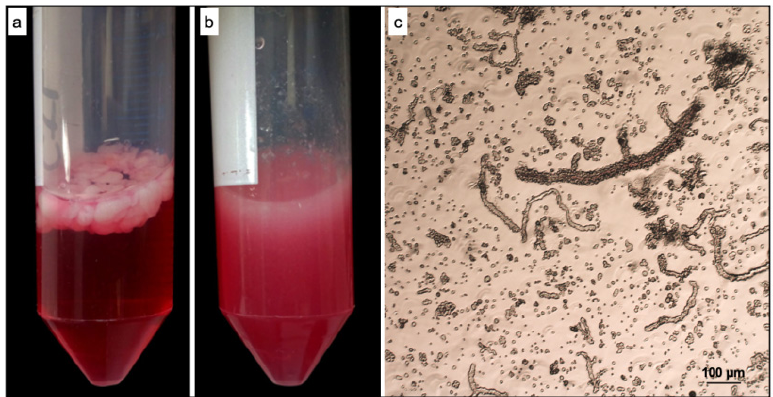
Figure 1. Isolation of stromal vascular fragments (ad-MVFs) from rat adipose tissue. ( a ) Rat adipose tissue before digestion. ( b ) Rat adipose tissue after digestion. ( c ) Optical microscopy image of freshly isolated ad-MVFs.